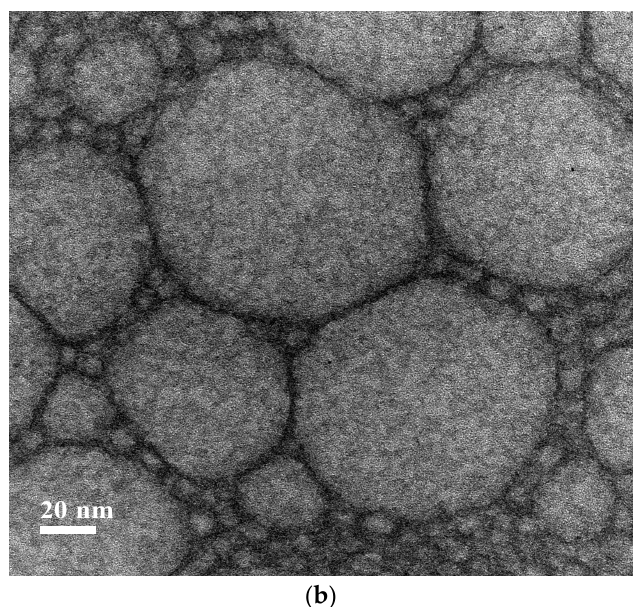
Figure 4. Representative TEM images of the optimized Ucuùba fat NLC formulations ( a ) F 30 and ( b ) F 85 (magnification 100,000x).